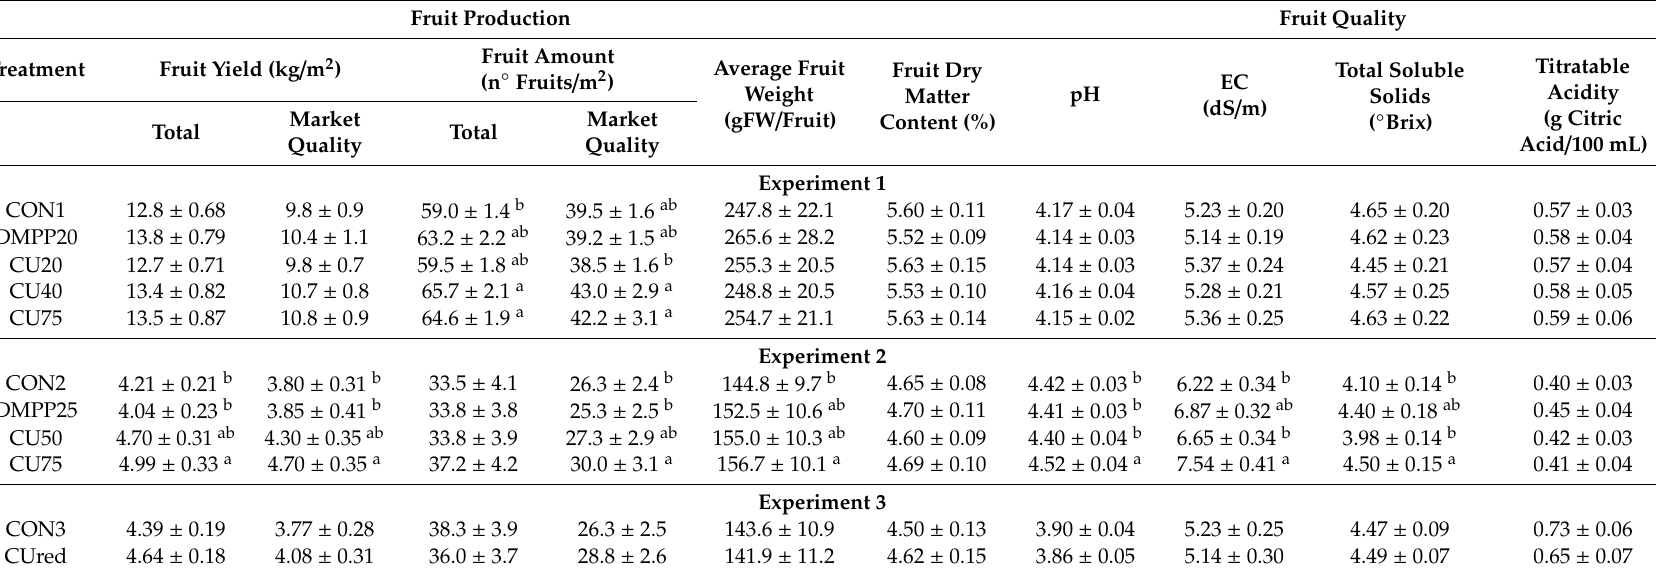
Table 6. The influence of di ff erent fertilization strategies on yield and quality of the tomato